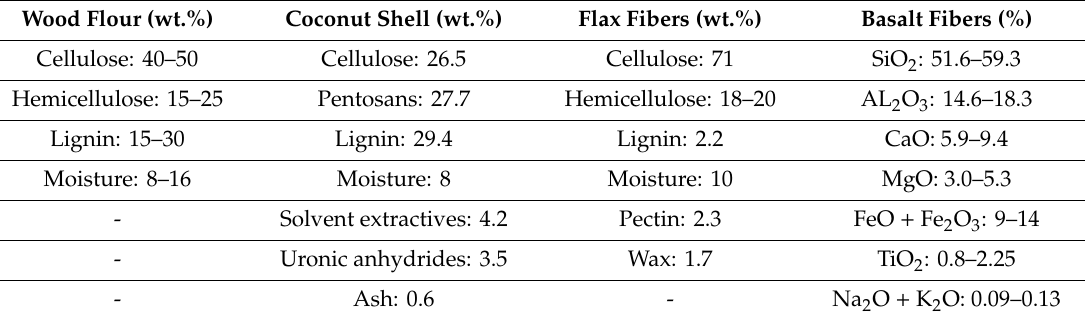
Table 2. Chemical composition of used fibers.